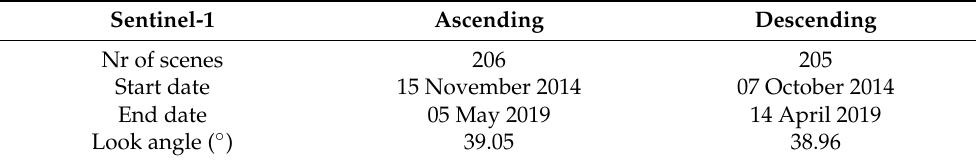
Table 1. Description of the analyzed dataset.